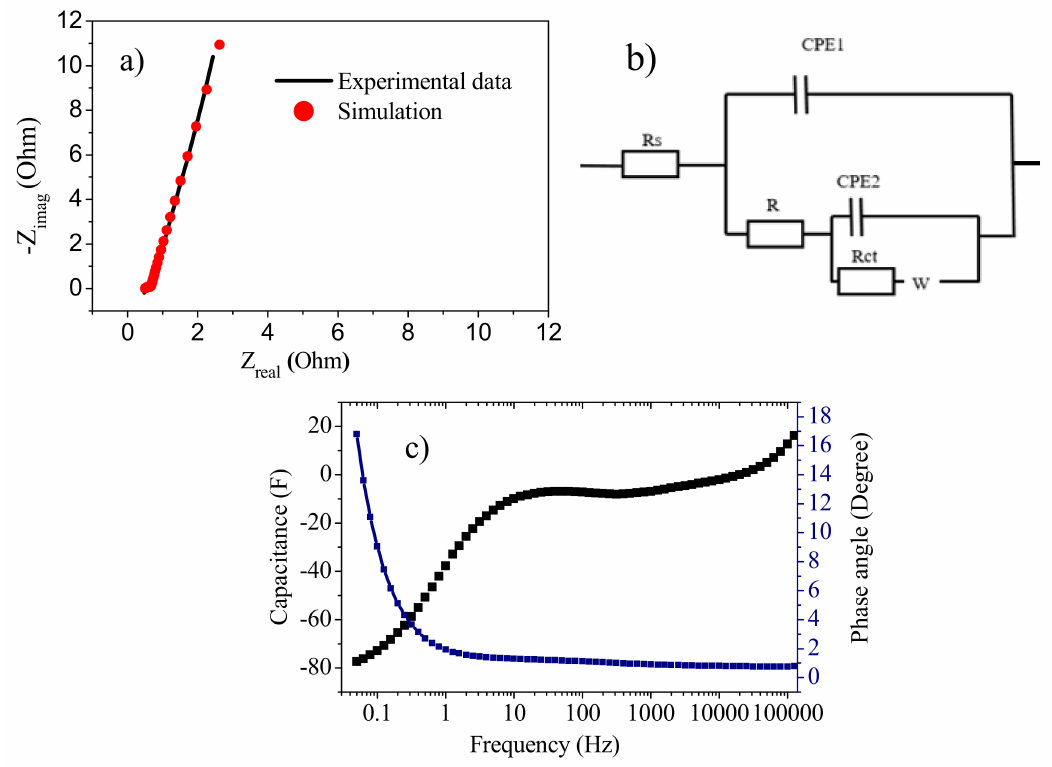
Figure 12. ( a ) Nyquist plot. ( b ): Equivalent circuit model. ( c ) Bode plot of the solid-state symmetric device fabricated with gold as current